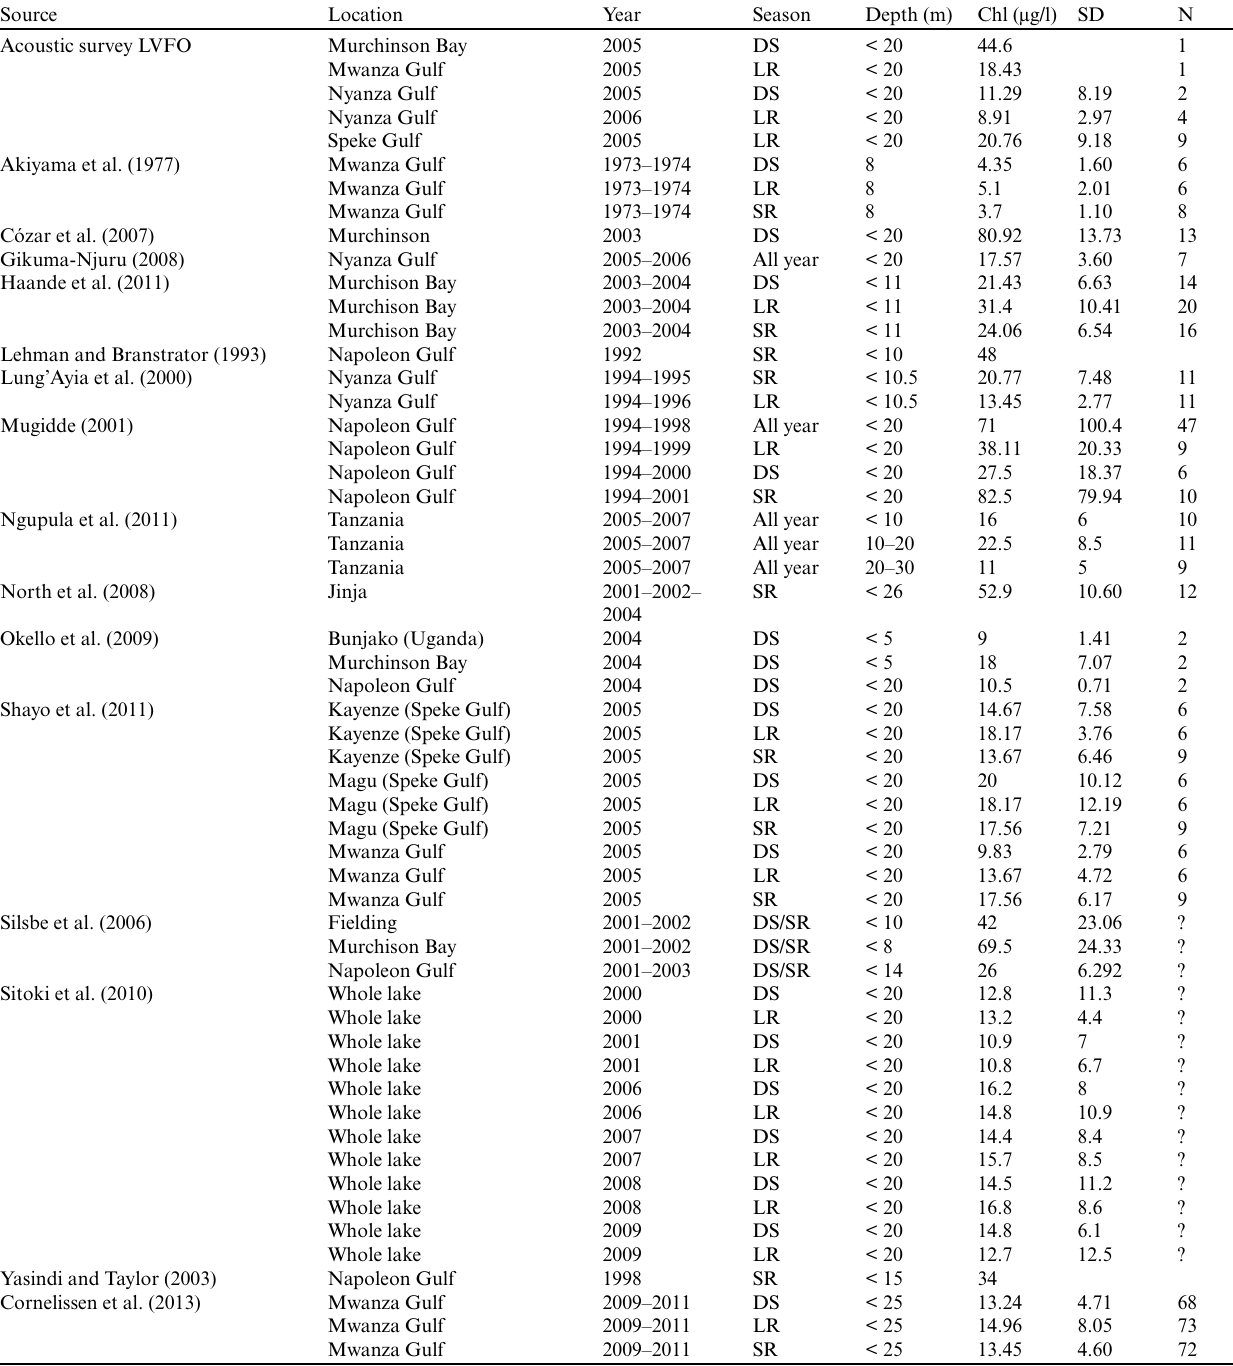
Table 4 . Variability in chlorophyll a (Chl) concentrations in the lake, as found in the literature. Seasons: DS = (dry season): June– August; SR = (short rains): September–December, LR = (long rains): January–May. SD = standard deviation. N = number of measures. LVRO = Lake Victoria Fisheries